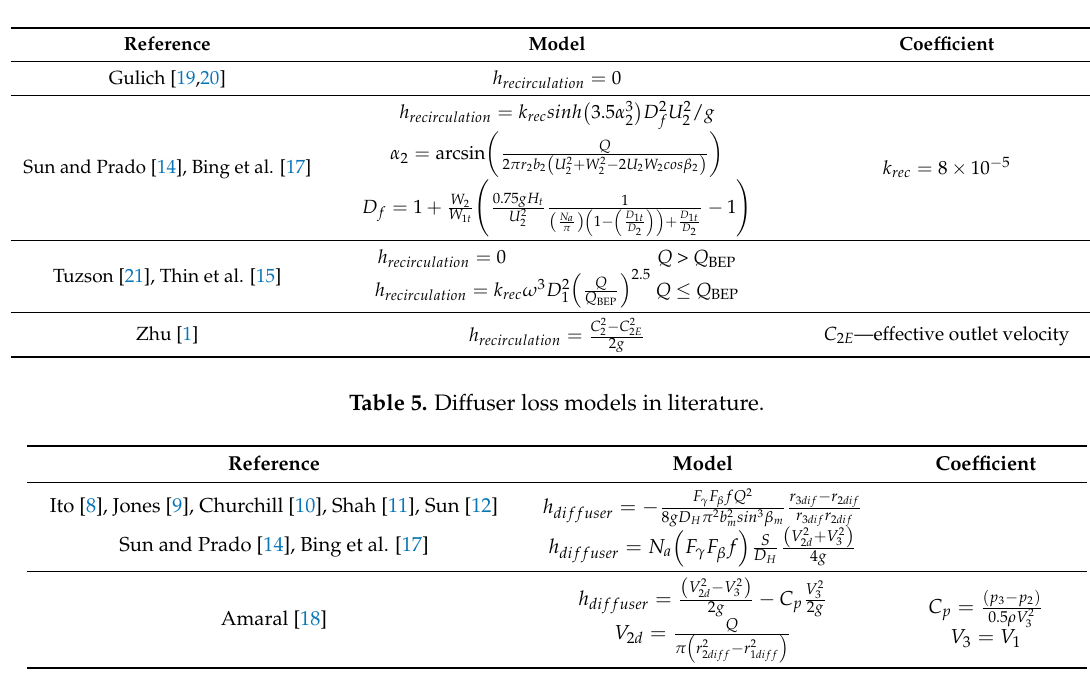
Table 4. Recirculation loss models in literature.